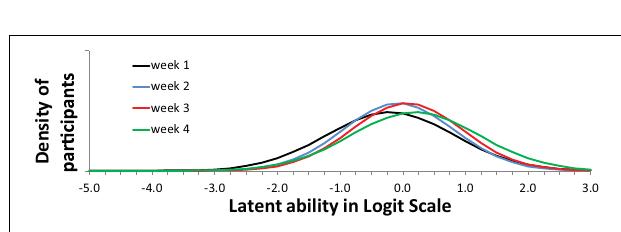
FIGURE 8 | Model Implied (expected) week trends of use of categories (levels of understanding).